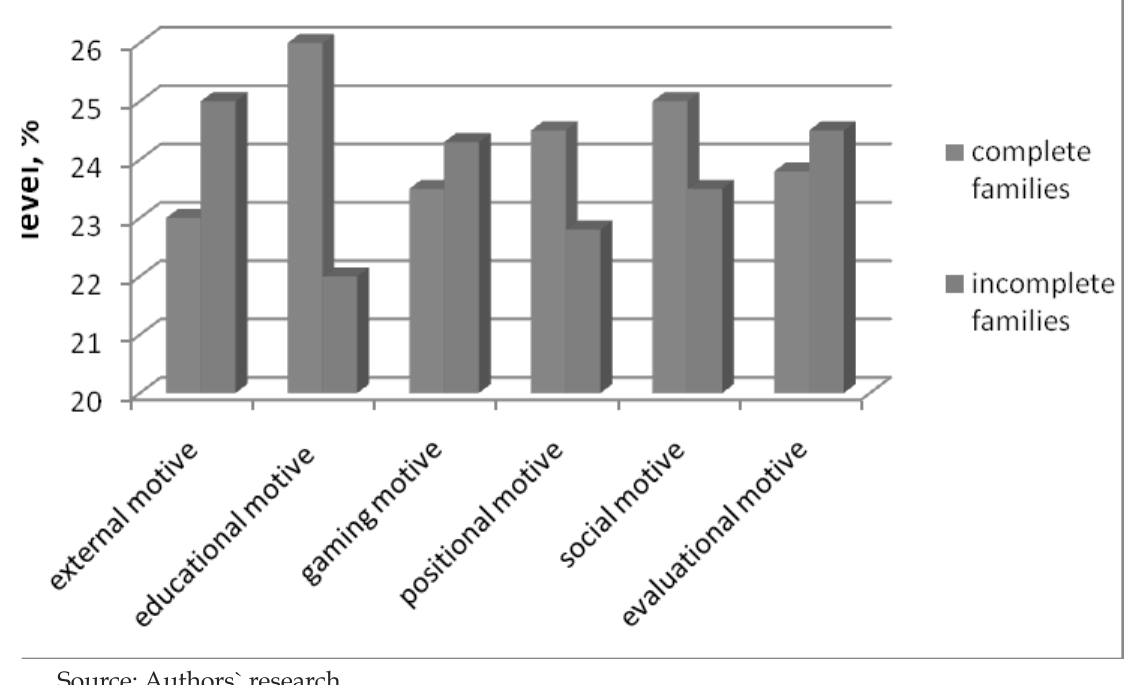
Fig. 2. Differences in learning motivation among children with nuclear and single parent families according to motivational research studies in older preschoolers by Michail Ginsburg